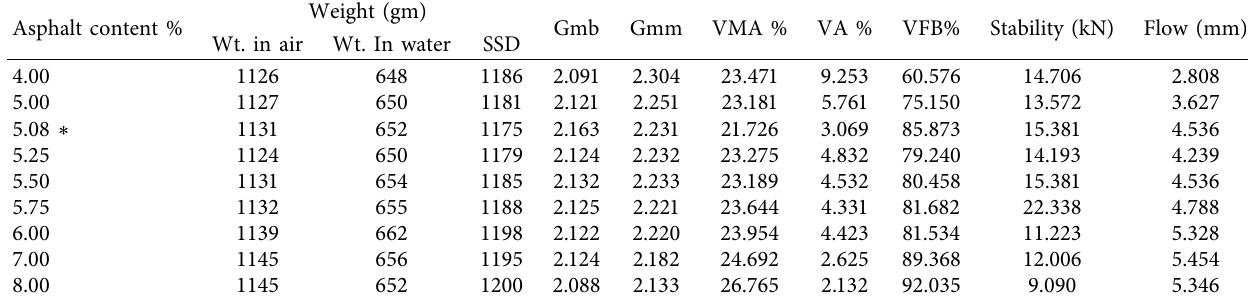
Table 9: Volumetric parameters of the AC mix with 5.5% CSD